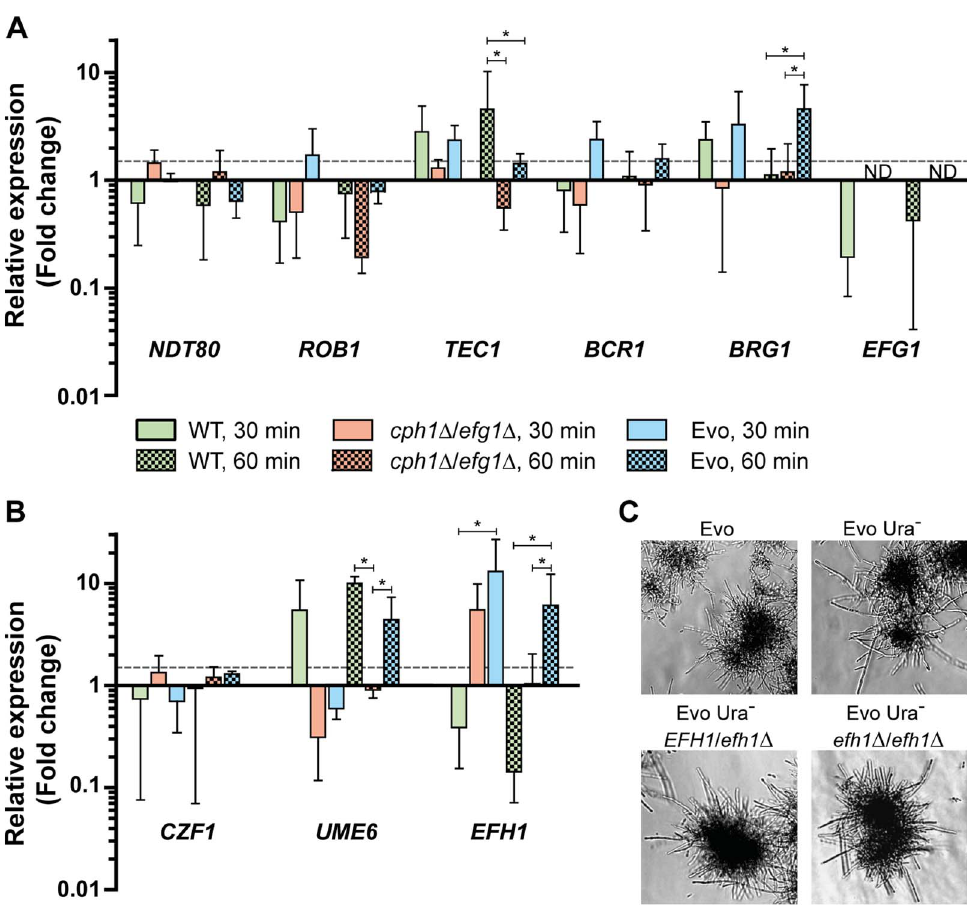
Fig. 4. Expression of transcription factors under filament-inducing conditions. ( A + B ) Relative expression of nine central transcription factor genes in the analyzed strains after growth in DMEM + 10% FBS at 37 u C and 5% CO 2 on a plastic surface. Fold change between filament-inducing and yeast promoting conditions (YPD, 30 u C) is shown, normalized to three housekeeping genes ( ACT1 , EFB1 and PMA1 ). Means + SD of n=3 (dotted line indicates threshold at 1.5; *p , 0.05). ( C ) Deletion of EFH1 in the Evo strain did not affect hyphal growth. Cells were incubated for 18 h at 37 u C and 5% CO 2 in DMEM + 10% FBS (representative pictures).